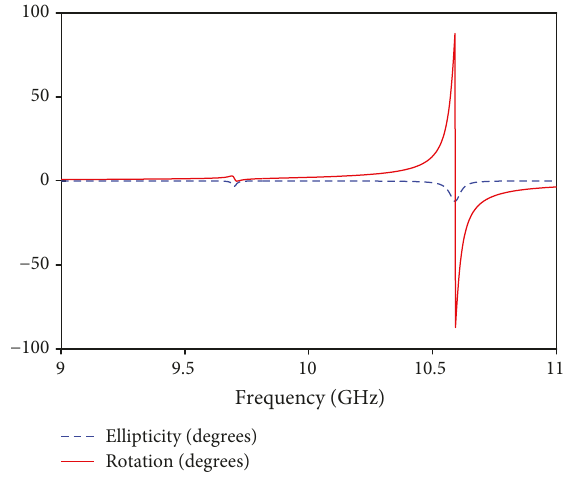
Figure 7: Rotation of the polarization plane and ellipticity of the transmitted wave after the data shown in Figure 4.